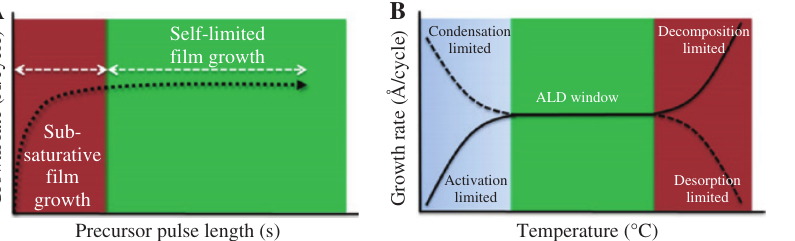
Figure 1: (A) Saturative precursor dose at the surface; (B) ALD window. Reprinted with permission from Ref. [14]. Copyright 2013 Elsevier